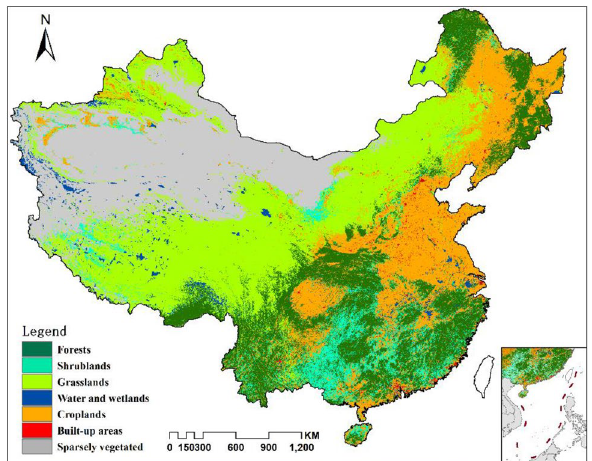
Figure 1. The research area and the major land-cover types in 2010 from MODIS land cover product (MCD12Q1 UMD). The fig was generated using the ArcGIS Desktop (ESRI, Inc, Version 10.2, https:// deskt op. arcgis. com/ zh-